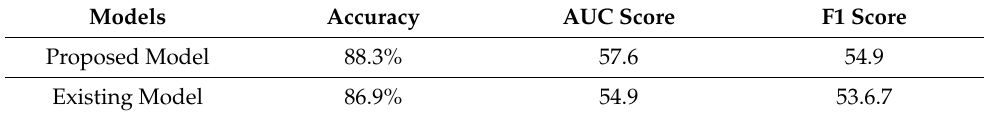
Table 6. Robustness Performance of Proposed Model against Unseen Theft